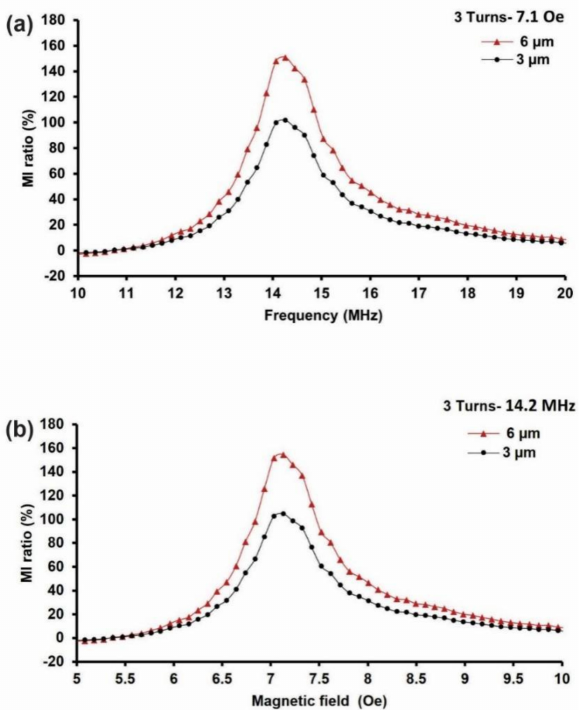
Figure 6. Results of the 3-turn MI biosensor based on different film thicknesses. ( a ) Frequency depen- dence of the MI ratio at 7.1 Oe. ( b ) Magnetic field dependence of the MI ratio obtained at 14.2